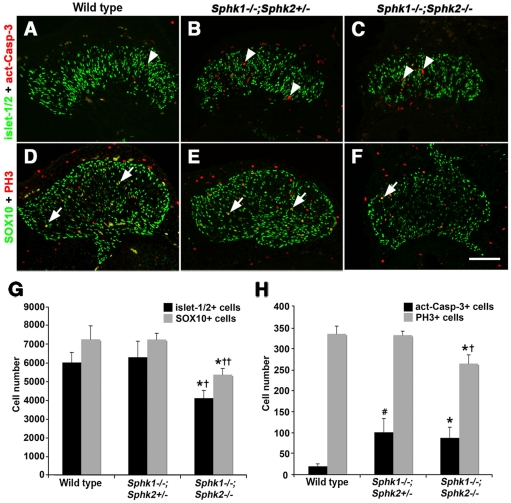
Loss of neurons and progenitor cells can be observed in E10.5 trigeminal ganglion in the Sphk1−/−;Sphk2−/− double mutant.(A–C) Trigeminal ganglion sections from wild type, Sphk1−/−;Sphk2+/−, and Sphk1−/−;Sphk2−/− were processed for activated Caspase 3 (red, act-Casp-3) and islet-1/2 (green, nuclear) immunofluorescence to identify dying cells and neurons, respectively. There are very few act-Casp-3+ cells in the wild type (A) trigeminal ganglion at E10.5 (32–35 somites). In comparison, both Sphk1−/−;Sphk2+/− (B), and Sphk1−/−;Sphk2−/− (C) trigeminal ganglia have a small but significant increase in act-Casp-3+ cells (arrowhead in B,C; black bars in H). Sphk1−/−;Sphk2−/− trigeminal ganglia are smaller and contain fewer islet-1/2 positive neurons compare to wild type and Sphk1−/−;Sphk2+/− ganglia (A–C; black bars in G). (D–F) Adjacent sections from those used in (A–C) were immunostained for phosphoshistone H3 (PH3, red) and SOX10 (green, nuclear) to identify dividing cells and neural crest progenitors, respectively. (D–F) PH3+ cells can be found throughout the trigeminal ganglia in all three genotypes examined and some PH3+ are dually positive for SOX10 (white arrowheads in D–F). There are fewer PH3+ and SOX10+ cells in Sphk1−/−;Sphk2−/− trigeminal ganglion (F; grey bars in G,H). (G) Quantification of the total number of islet-1/2+ (neurons, black bars) and SOX10+
(progenitor cells, grey bars) cells reveals that while the number of neurons and progenitor cells are similar in E10.5 wild type and Sphk1−/−;Sphk2+/− trigeminal ganglia, both islet-1/2+ and SOX10+ cells are significantly reduced in Sphk1−/−;Sphk2−/−. n = 3 embryos from each genotype; * = Sphk1−/−;Sphk2−/− to wild type comparison, p<0.05; † = Sphk1−/−;Sphk2−/− to Sphk1−/−;Sphk2+/− comparison, p<0.05; †† = Sphk1−/−;Sphk2−/− to Sphk1−/−;Sphk2+/− comparison, p<0.01. (H) Quantification of the total dying (act-Casp-3+, black bars) and dividing (PH3+, grey bars) cells confirms that there is very little cell death in E10.5 wild type trigeminal ganglion. A small but significant increase in the number of dying cells can be seen in Sphk1−/−;Sphk2+/− and Sphk1−/−;Sphk2−/− double mutant compared to the wild type. n = 3 embryos from each genotype; * = Sphk1−/−; Sphk2−/− to wild type comparison, p<0.05; # = Sphk1−/−;Sphk2+/− to wild type comparison, p<0.05; † = Sphk1−/−;Sphk2−/− compare with Sphk1−/−;Sphk2+/−, p<0.05. Scalebar for A–F = 100 µm.